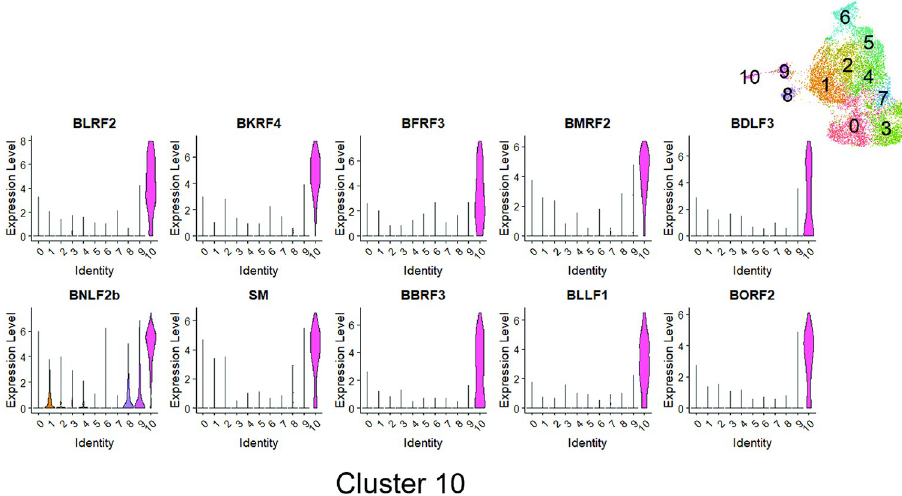
Fig 17. Gene expression analyses of Cluster 10. Violin plot of log normalized expression level of the top 10 differentially expressed genes sorted by average log2FC from MAST method (see Materials and Methods) across 11 identified clusters for Cluster 10 are